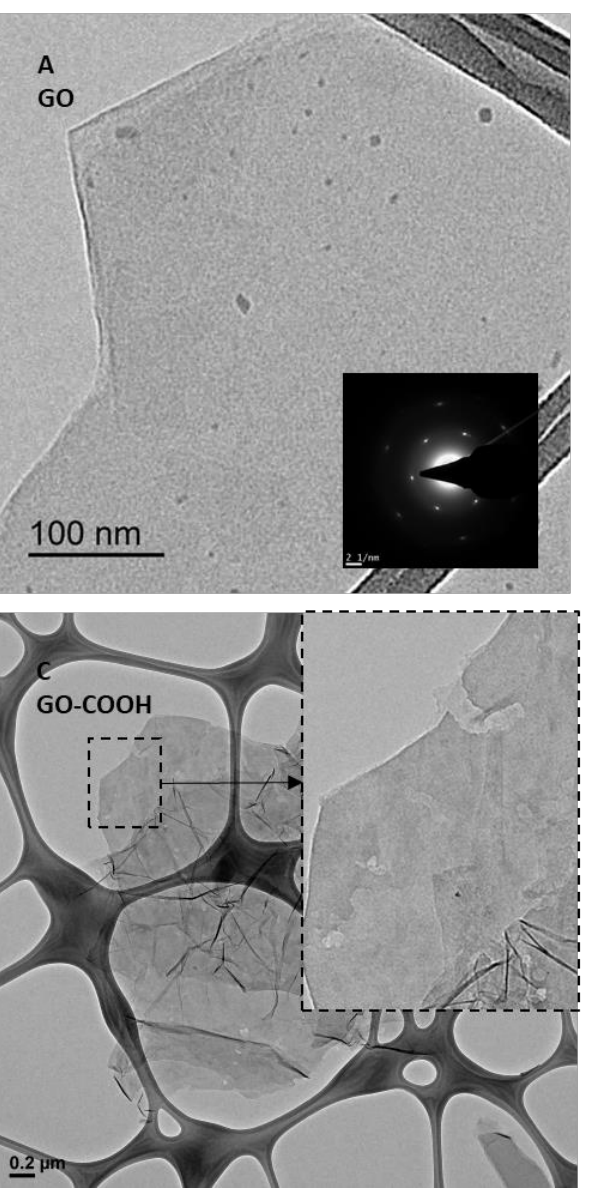
Figure 1. ( A ) Single-layer GO sheet from GrO exfoliated by liquid-phase sonication; the morphology is flat without visible damage. ( B ) Thermally microwave-exfoliated rGO, showing roughness. ( C ) Wrinkled GO-COOH sheet, presenting with very clear damage and holes in both edges and the basal plane. ( D ) Wrinkled GO-COOH sheet with a flat zone, which indicates a single-layer according to its EDP (insert).